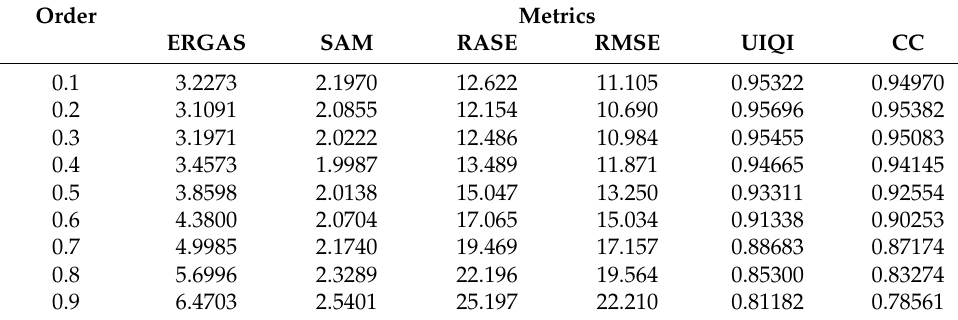
Table 5. Results for derivative based on FFT.